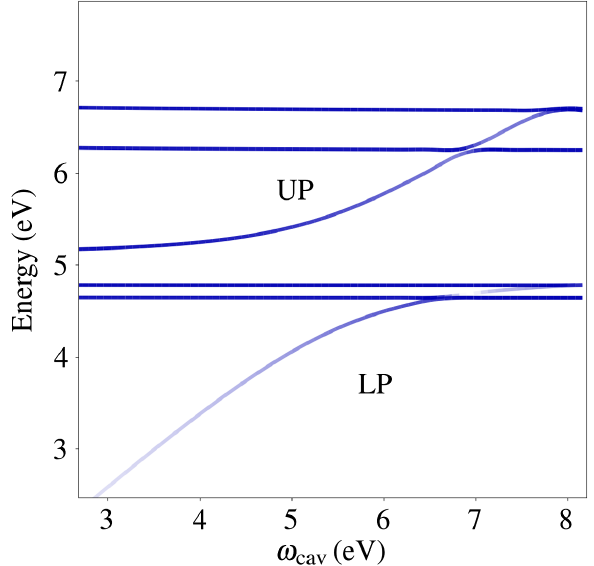
FIG. 4. QED-CCSD-1 dispersion with respect to cavity fre- quency ω of the excitation energies in PNA. The blue color cav map indicates the electronic or photonic character of the states.